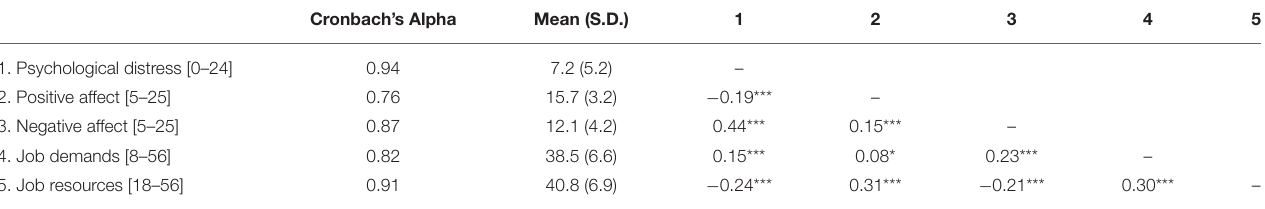
TABLE 2 | Descriptive statistics and correlations of key variables.